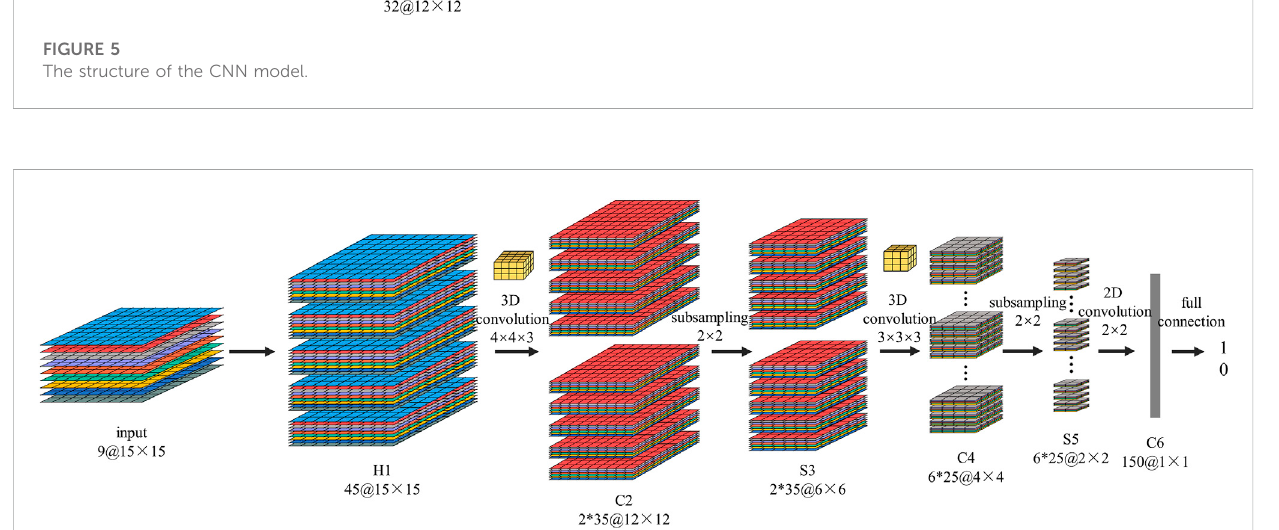
FIGURE 6 The architecture of the 3D augmented convolution kernel neural